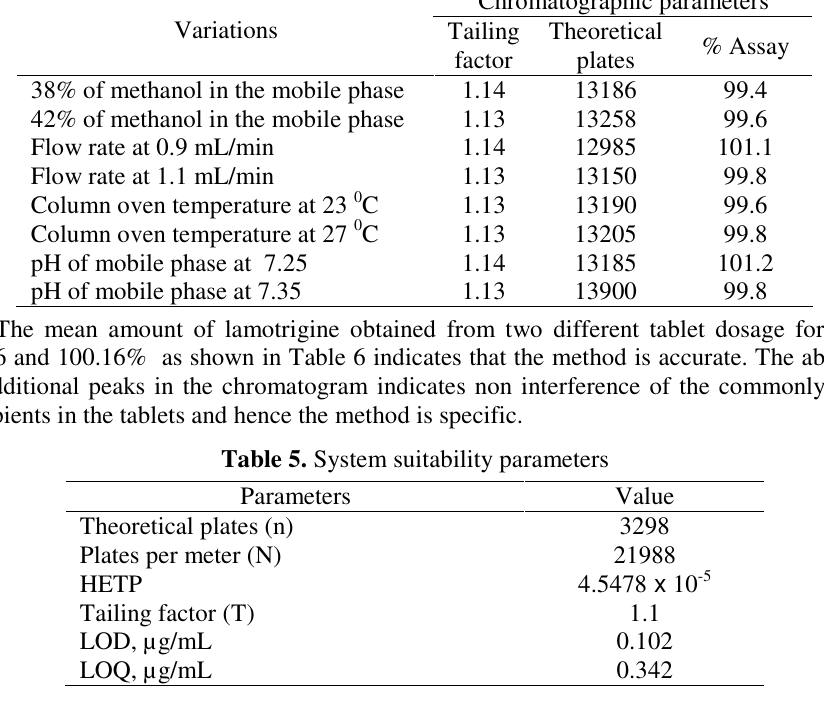
Table 6. Recovery of lamotrigine from tablets